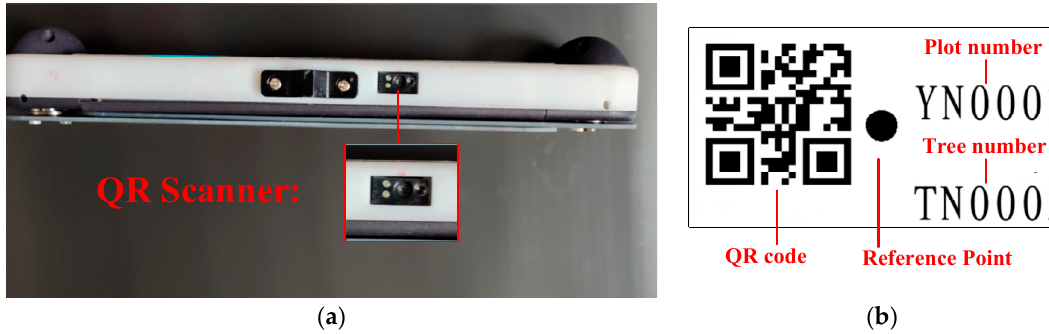
Figure 2. The QR scanner and an example of a tree code: ( a ) QR scanner ( b ) coded sticker